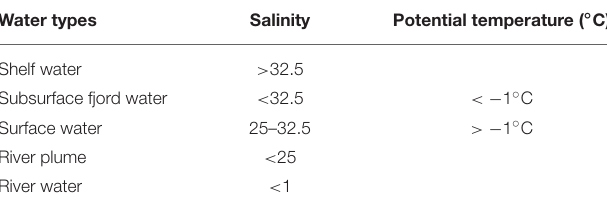
TABLE 1 | Thermohaline properties describing the classification of water